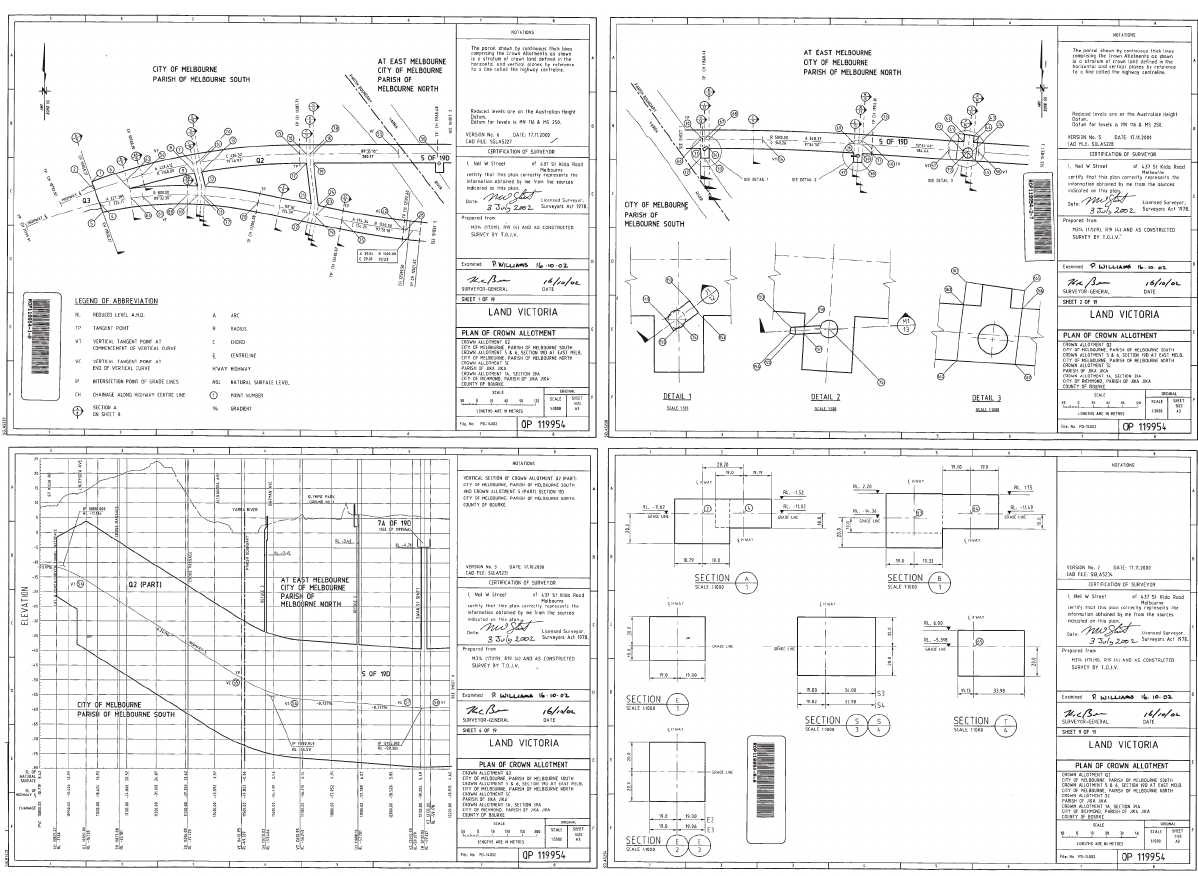
Figure 2. sample of Crown Allotment plan showing a tunnel in Melbourne